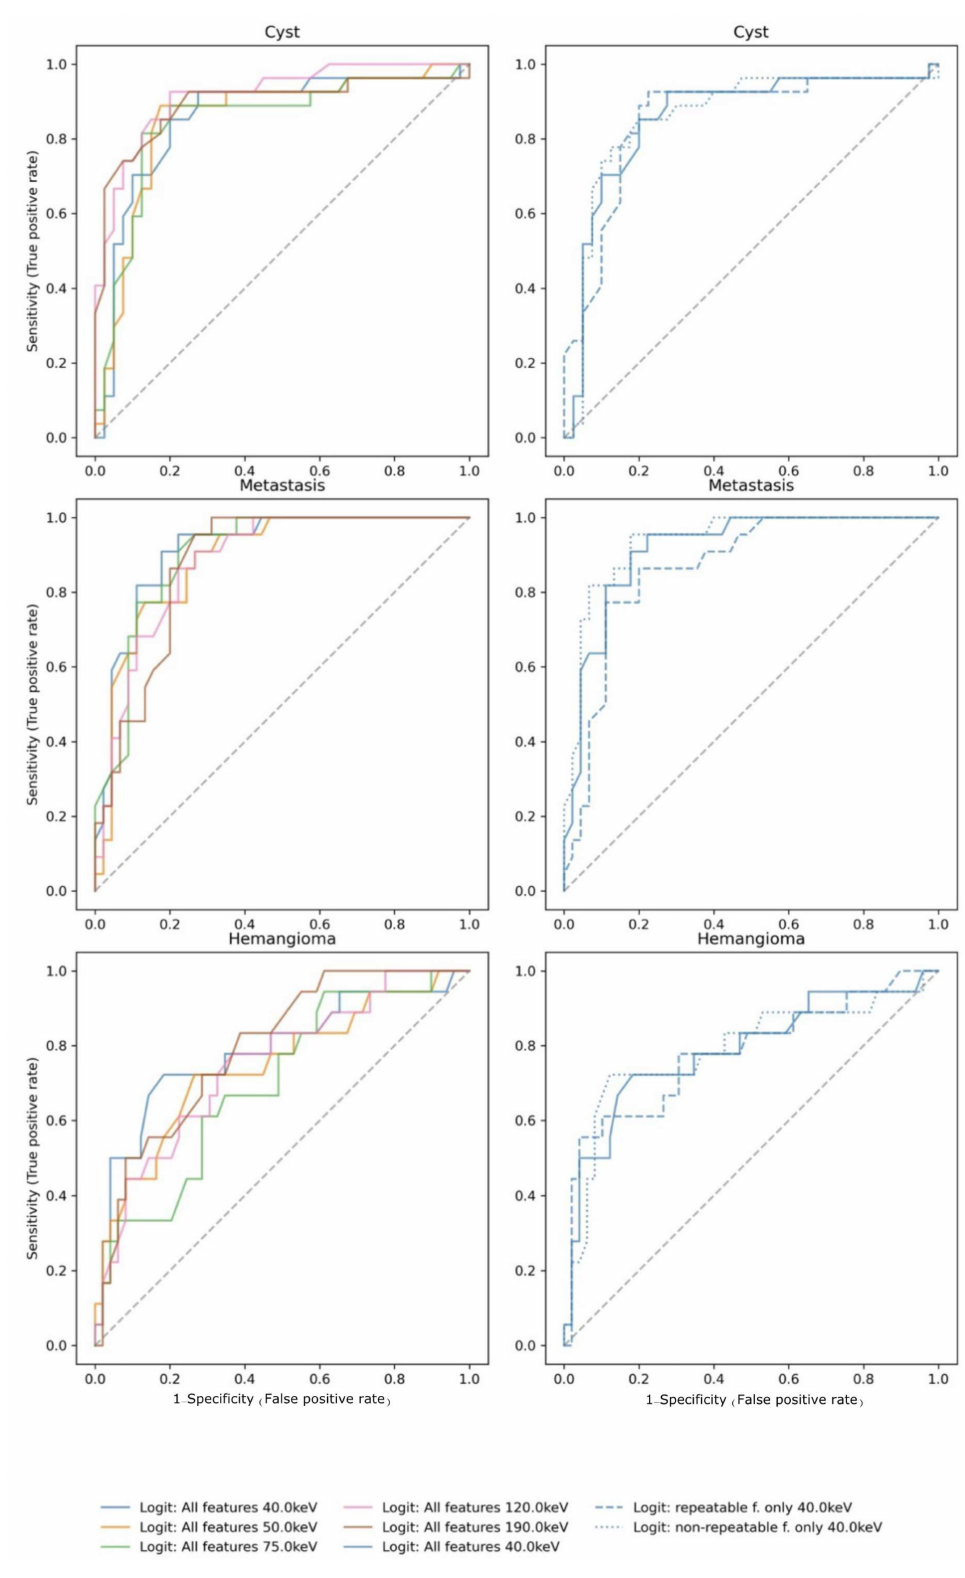
Figure 5. Receiver operating characteristics of the penalized logistic regression model for classification of cysts, metastases, and hemangioma by VMI energy (left column) and feature subset (right column), respectively. Color indicates VMI energy. Line style indicates the used feature subset (‘all features’, ‘repeatable only’, ‘nonrepeatable only’) at 40